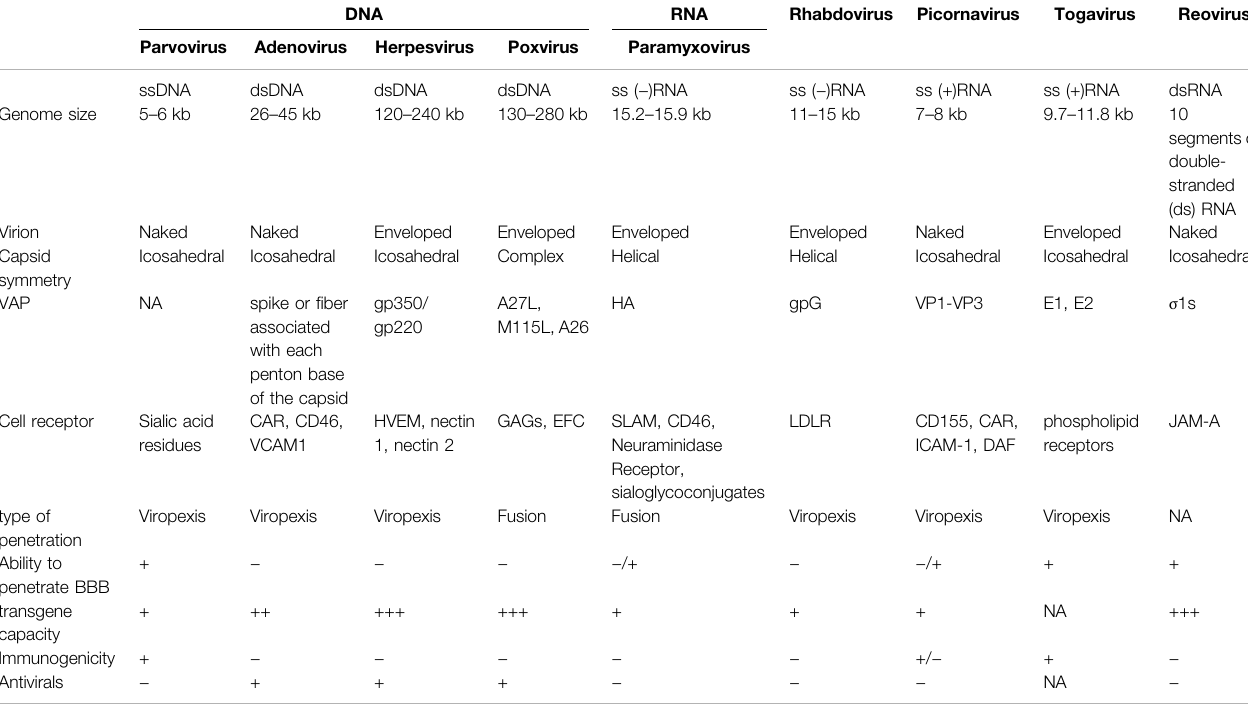
TABLE 1 | The unique characteristics of oncolytic virus.